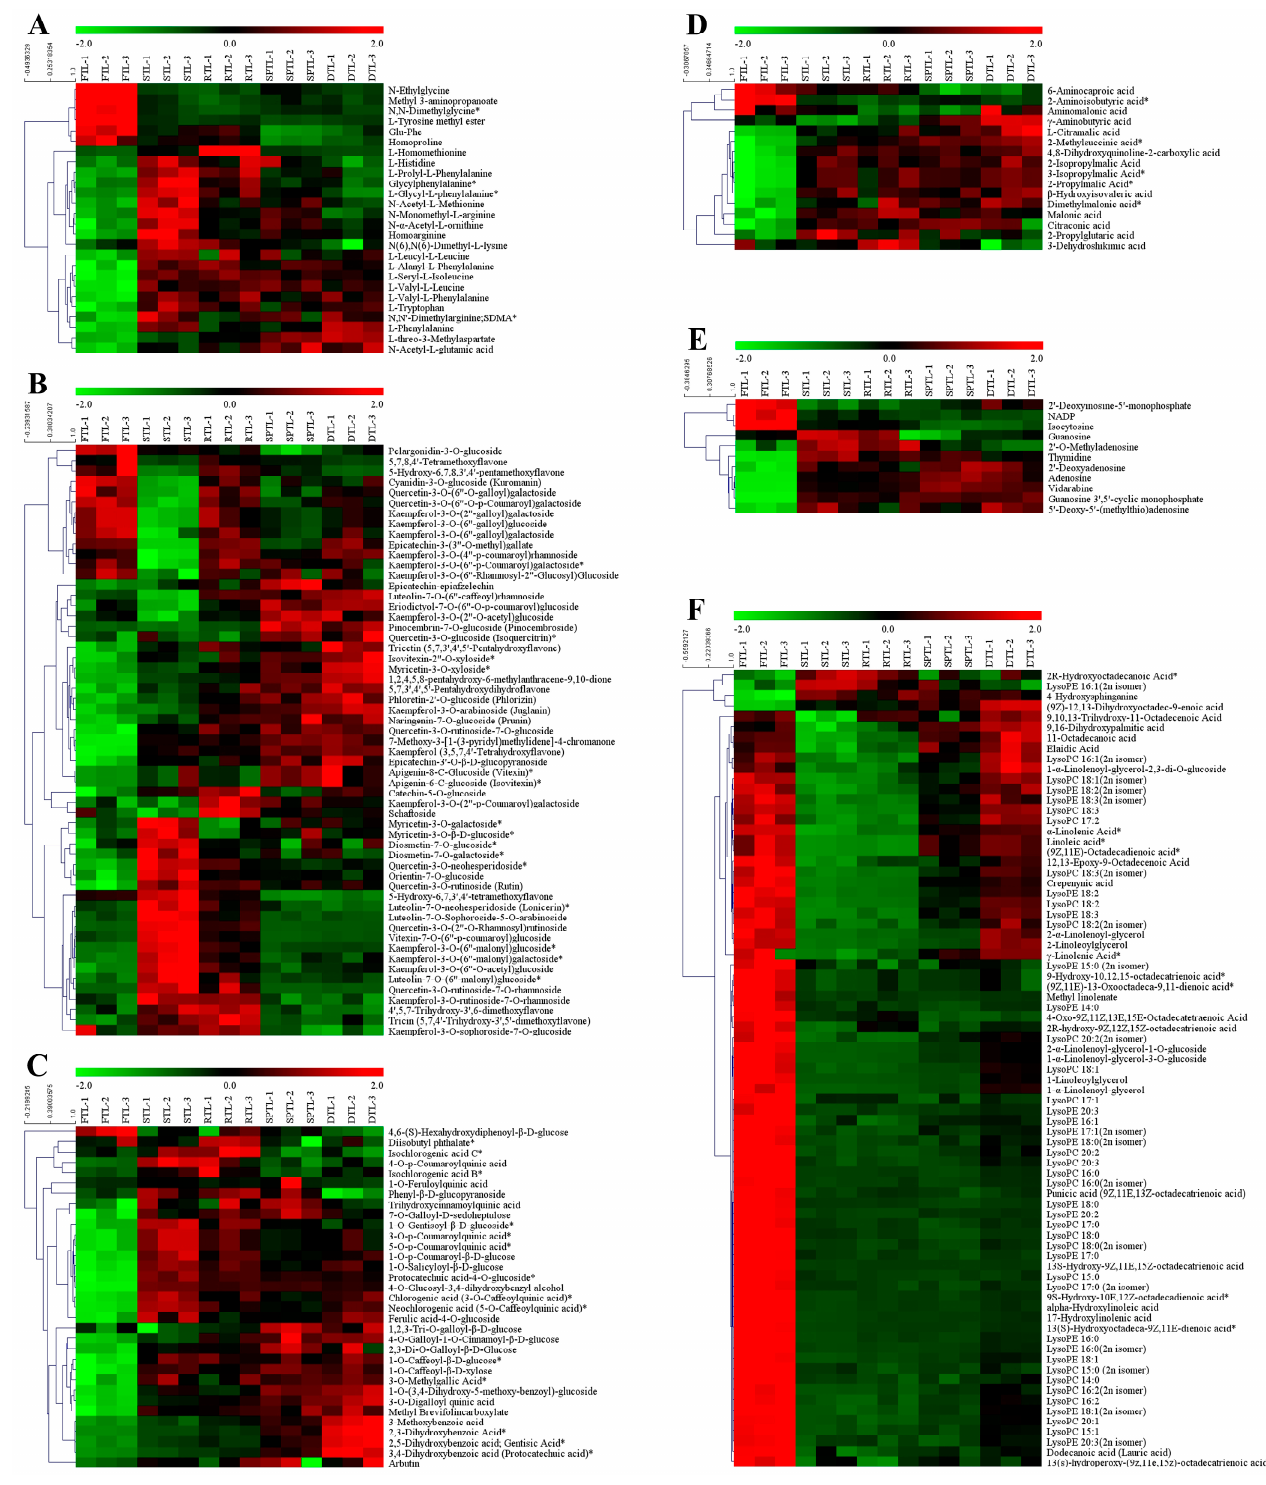
Figure 5. Heat map of the levels of differential non-volatile compounds throughout the processing period. The data were UV-scaled and clustered according to Pearson correlation coefficients. ( A ) Amino acids and their derivatives; ( B ) flavonoids; ( C ) phenolic acids; ( D ) organic acids; ( E ) nucleotides and their derivatives; ( F ) lipids. “*” indicates the presence of isomers of the substance.